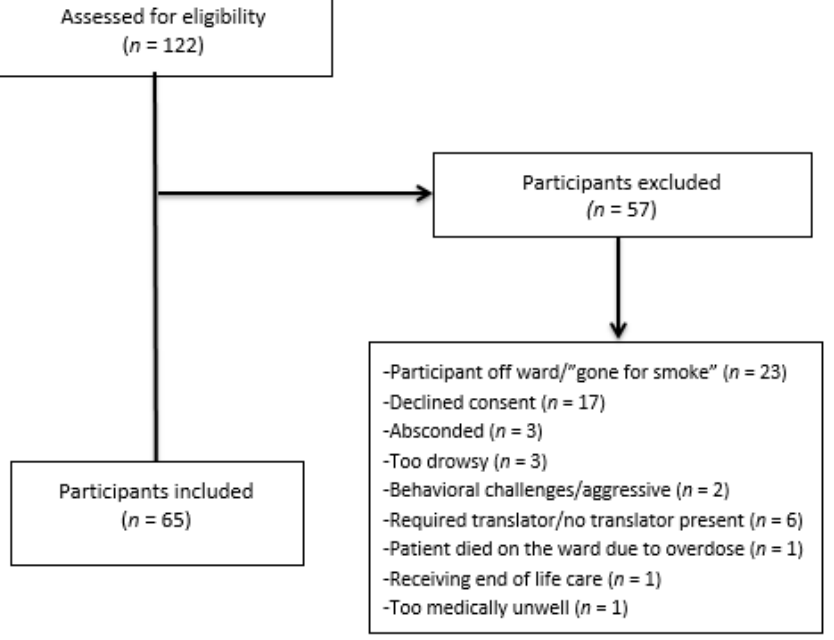
Figure 1. Flow diagram of participants through the study. Table 2. Demographic characteristics of